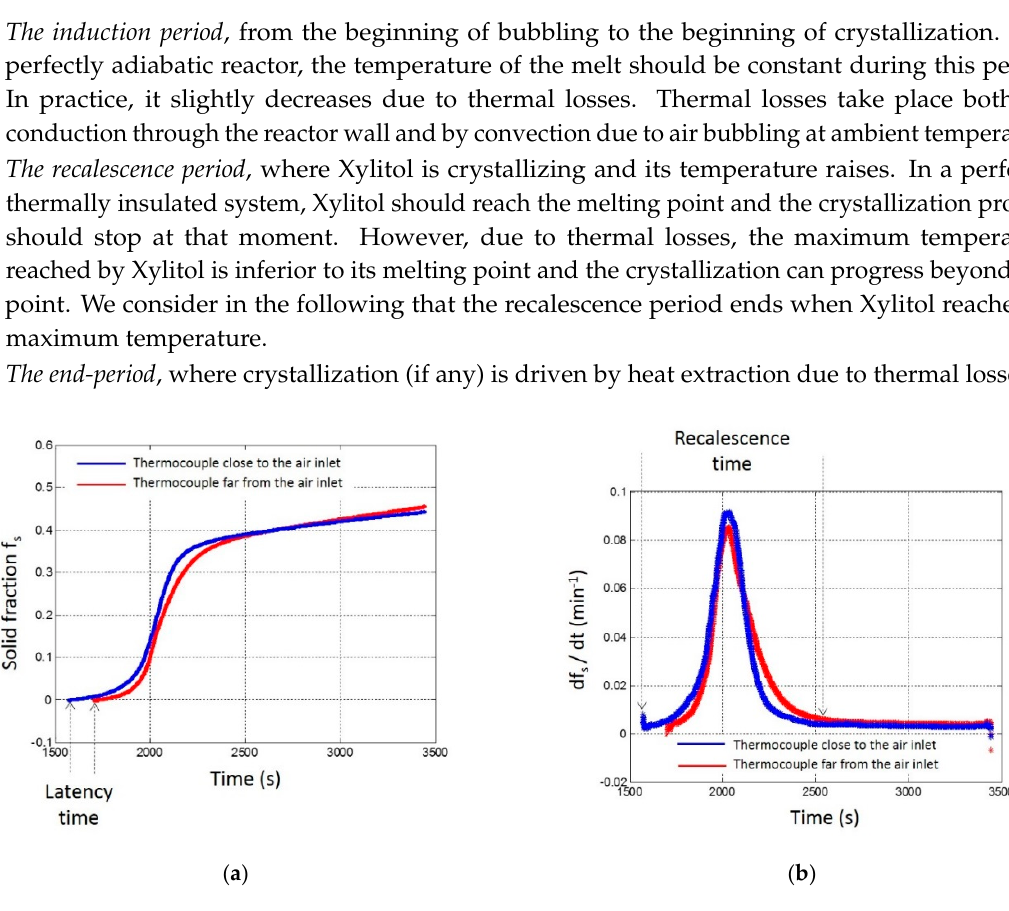
Figure 9. Time evolution of the solid fraction ( a ) and time behavior of the crystallization rate ( b ) calculated from the temperature data obtained using both